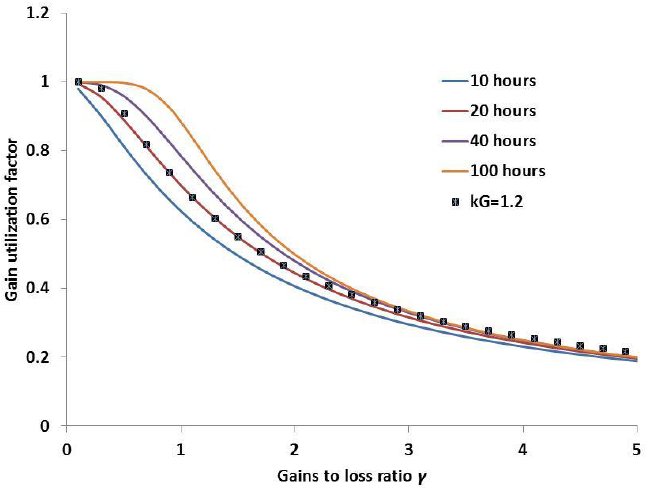
Figure 5. Gains utilization factor for various time constants, and estimations according to Equation (21) with k G = 1.2).